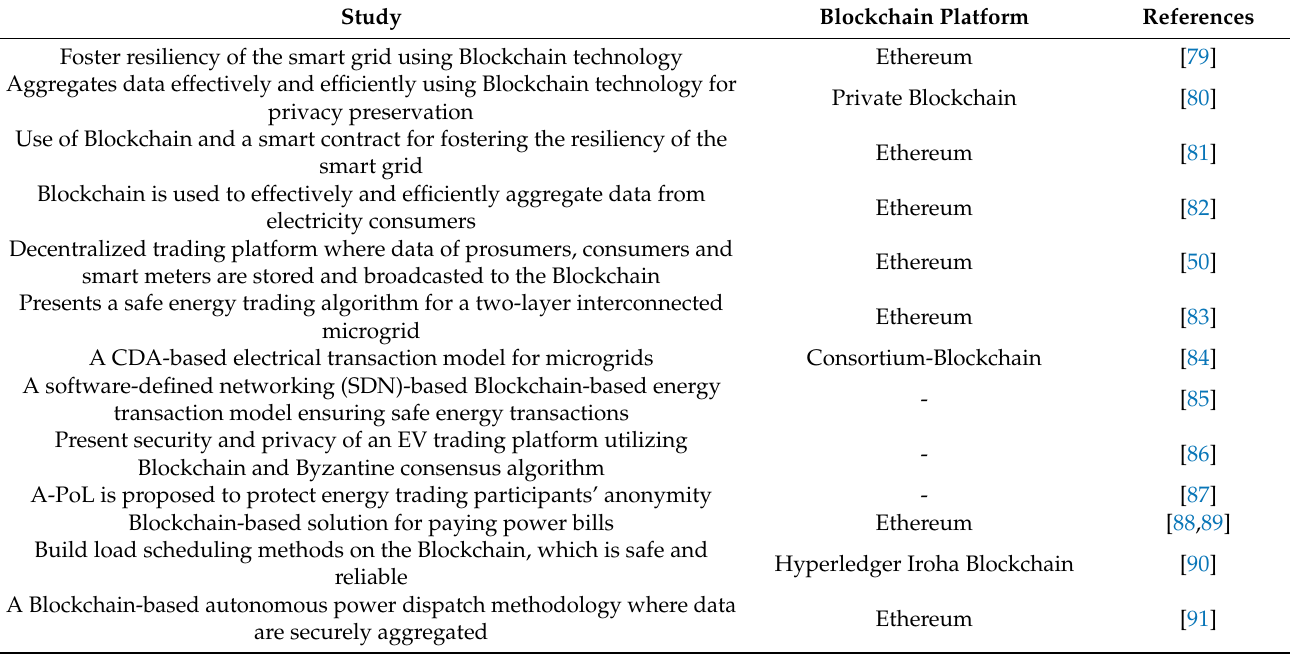
Table 8. Summary of publications employing Blockchain technology for security and